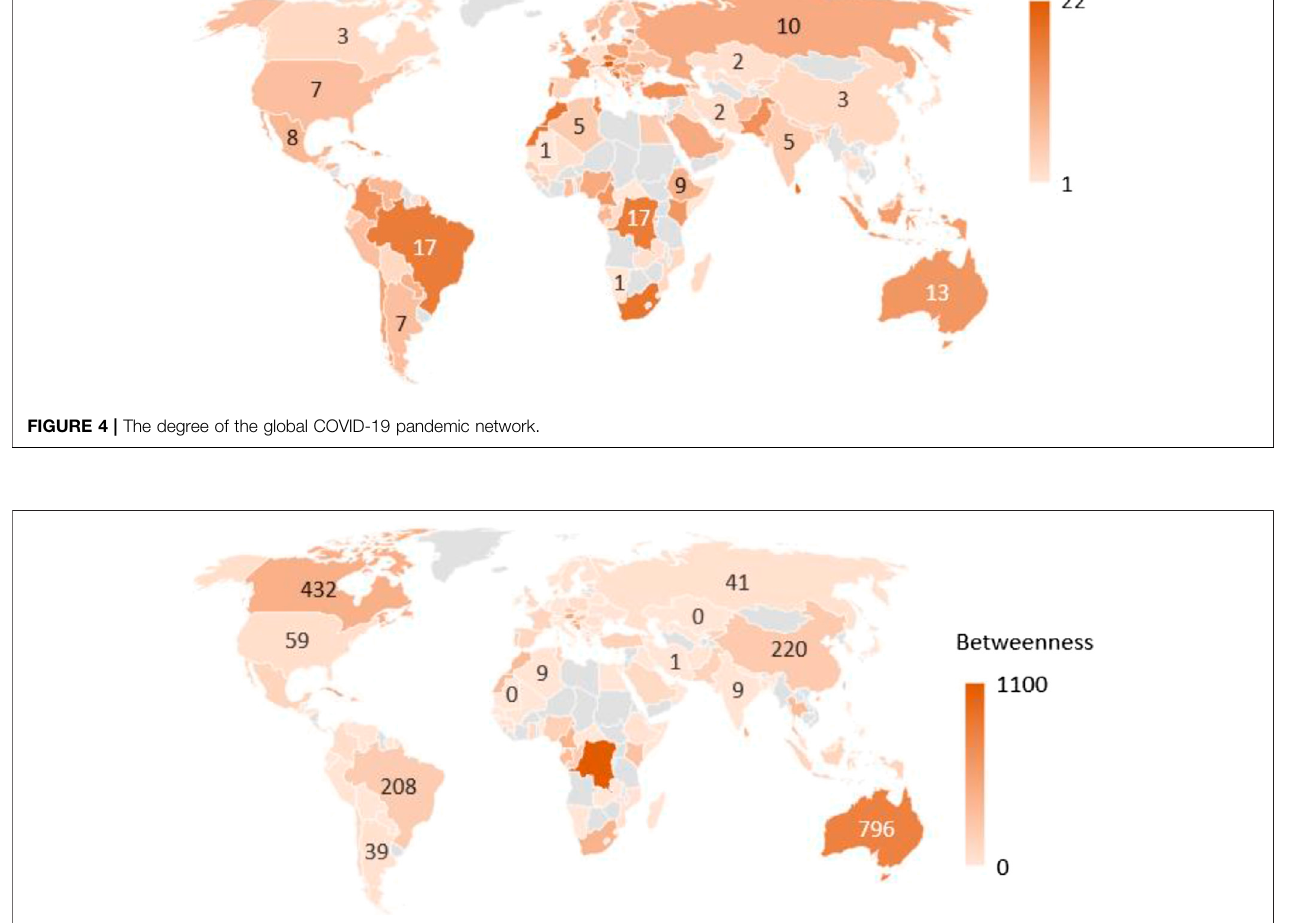
FIGURE 5 | The betweenness centrality of the global COVID-19 pandemic